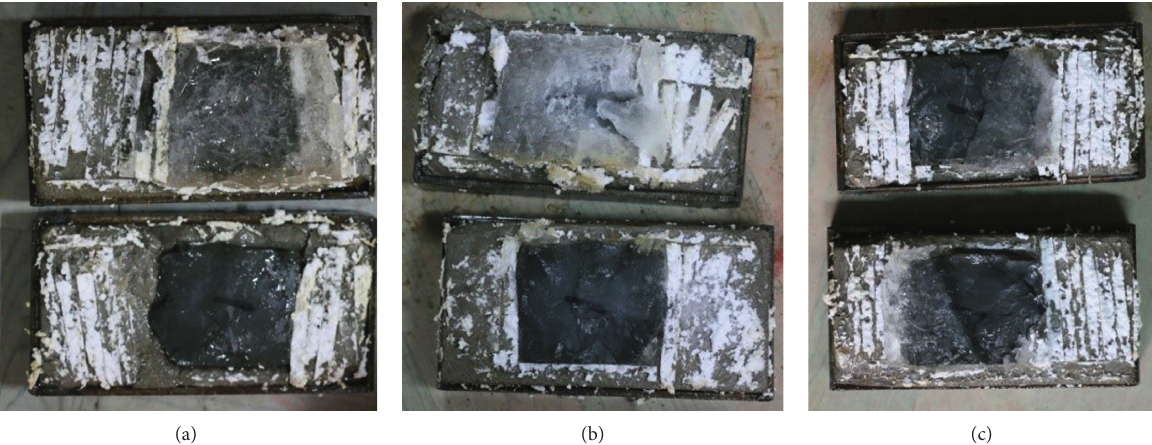
Figure 12: Photographs of shear failure patterns of frozen joints under different conditions. (a) Disengagement failure of the ice-rock interface. (b) Ice shear damage inside. (c) Shear failure in the ice layer.